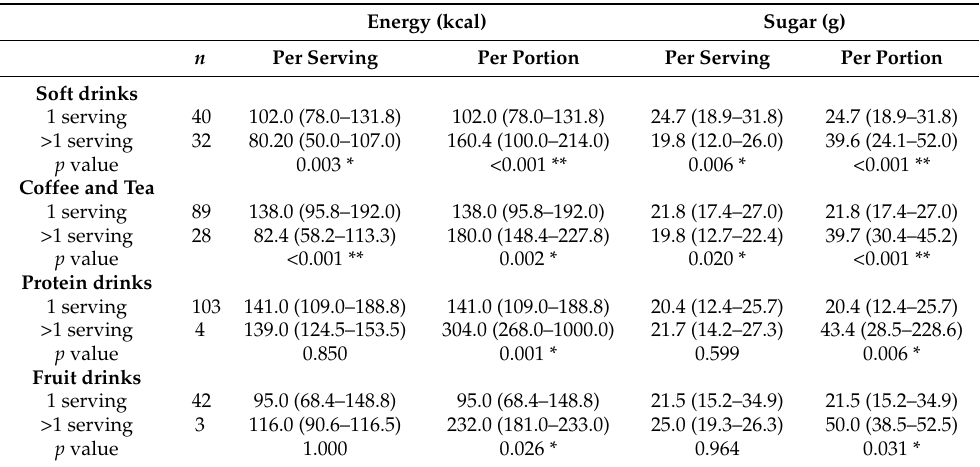
Table 4. Energy and sugar content in different numbers of servings among different types SSBs 1 . Energy (kcal) Sugar (g) n Per Serving Per Portion Per Serving Per